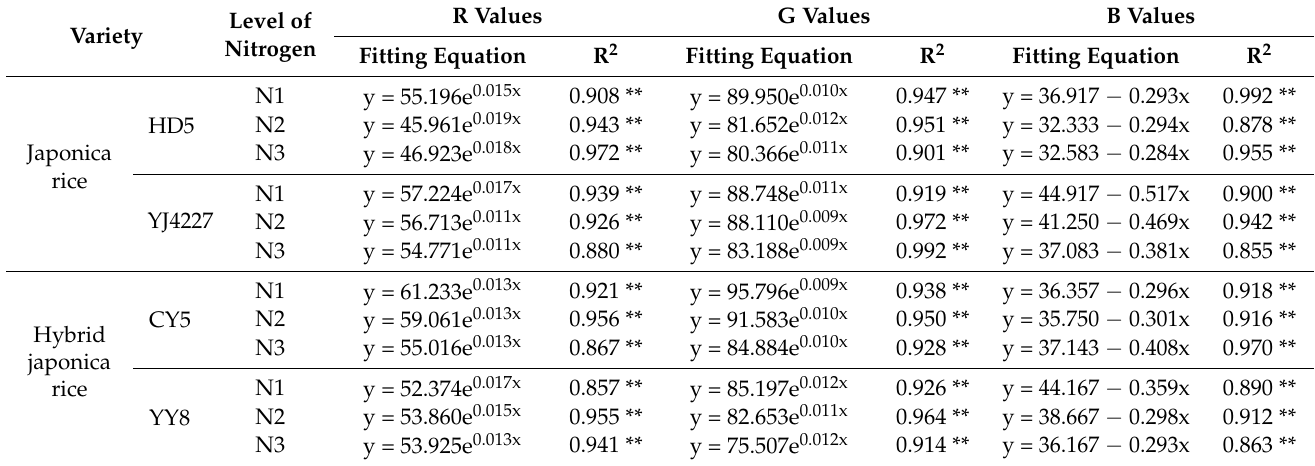
Table 5. Fitting equations of RGB components of leaves after anthesis—different varieties with different nitrogen levels (y = ae bx , y = a + bx).